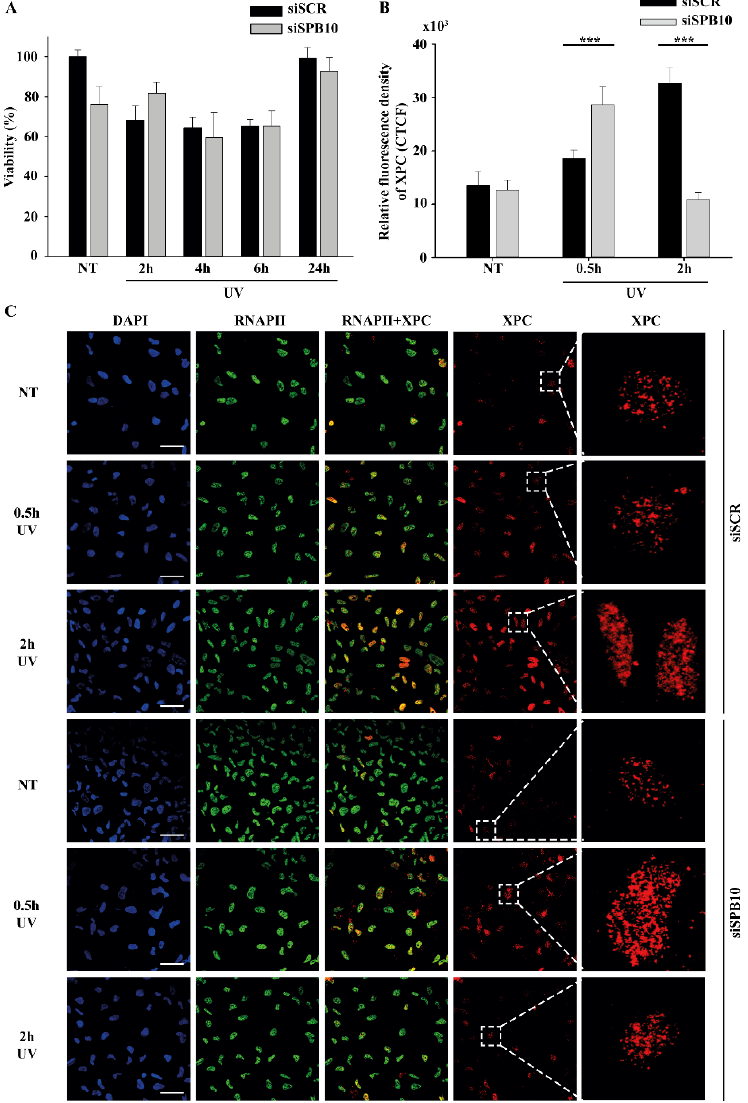
Figure 2. SPB10 is dispensable for cell survival but influences DNA repair kinetics in interphase cells upon UV irradiation: ( A ) Diagram represents cell viability (%) upon UV irradiation (2, 4, 6, and 24 h) of non-targeting (siSCR) and SPB10 siRNA-silenced U2OS cells. ( B ) Quantification of relative fluorescence intensity (CTCF) of Xeroderma Pigmentosum C (XPC) protein detected on non-targeting (siSCR) and SPB10 siRNA-silenced interphase U2OS cells in basal conditions (NT) and following UV irradiation (0.5 and 2 h). Asterisks indicate statistical significance between datasets (Mann–Whitney test, *** p ≤ 0.001). ( C ) Representative images of XPC protein (red) binding presumably to Nucleotide Excision Repair (NER) foci in non-targeting (siSCR, upstream) and SPB10 siRNA-silenced ( siSPB10 , downstream) U2OS cells in basal conditions (NT) and after UV irradiation (0.5 and 2 h). Only the chromatin-bound proteins were visualized by CSK-immunocytochemistry. DAPI (blue) was used to visualize the nuclei, and RNA Polymerase II (RNAPII) (green) was used as control. Scale bars represent 200 µm. For each condition, a higher magnification of a single cell is shown on the right side of the figure.